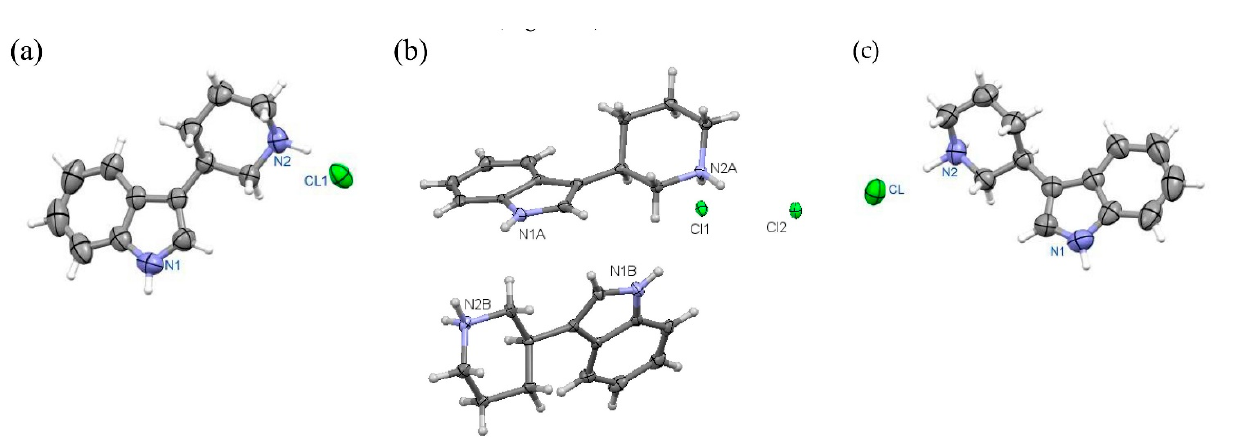
Figure 4. Perspective view of molecule 1b and 1c in racemic crystal [17,18] and view of molecular structure of enantiomeric fluoro-derivatives.